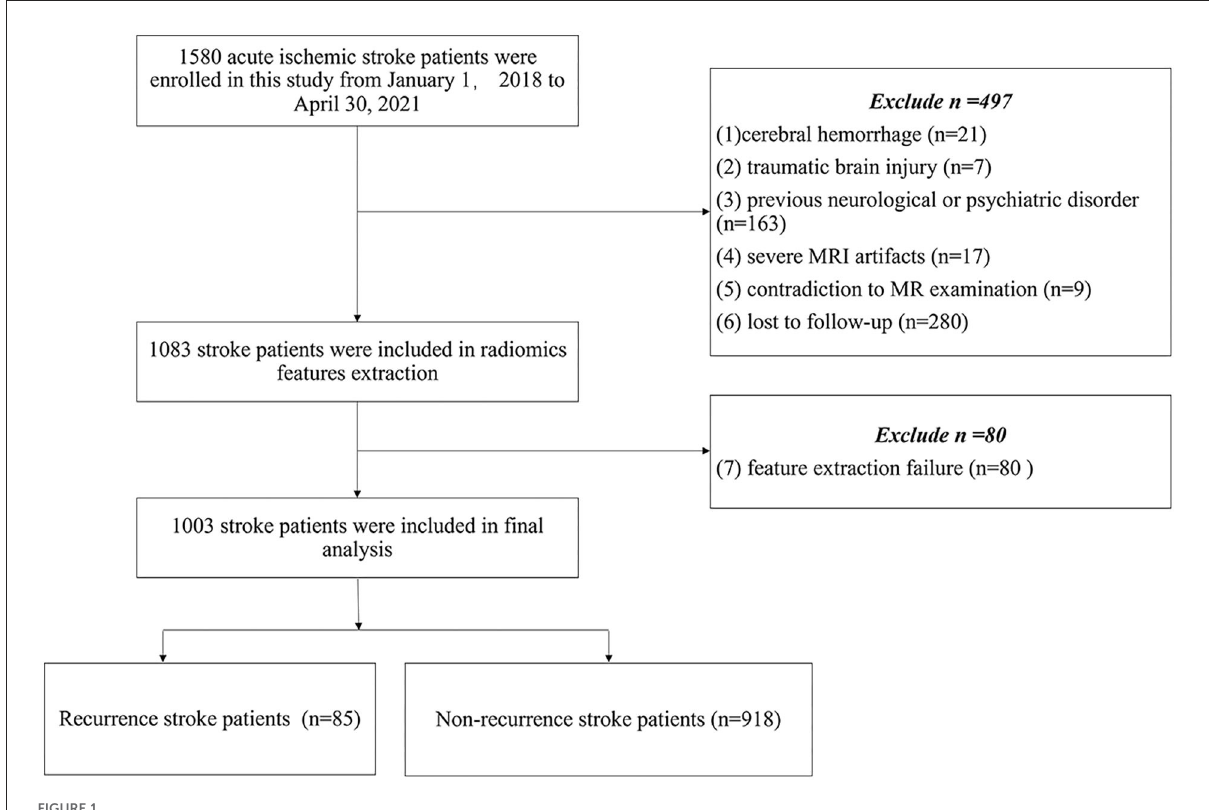
FIGURE1 Flow chart outlines study group selection.